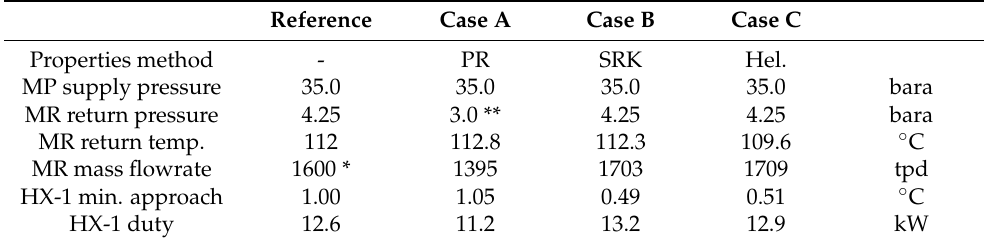
Table 6 Summary of modelling parameters for the model validation work. Table 6. Summary of modelling parameters for the model validation work.